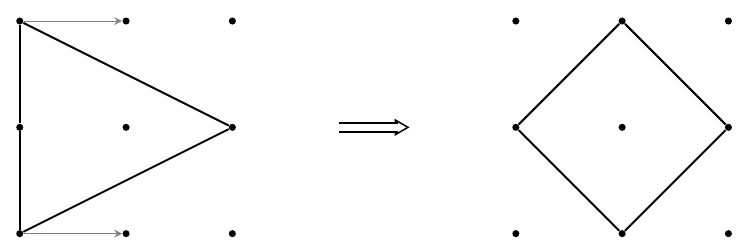
Figure 25. Mass deformation on C 3 = Z 4 (left) moves external nodes in the toric diagram, yielding C = Z 0 (right). 2